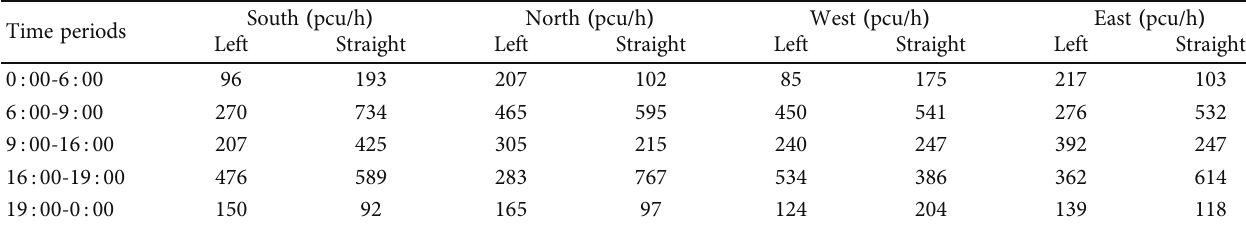
Table 3: All-day tra ffi c volume of each entrance at the